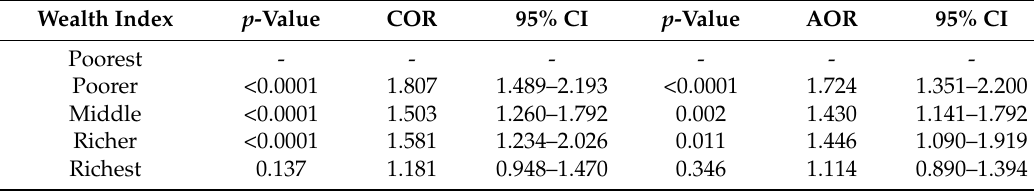
Table 3. Association between household wealth index and satisfaction with health status, Nepal MICS 2014.